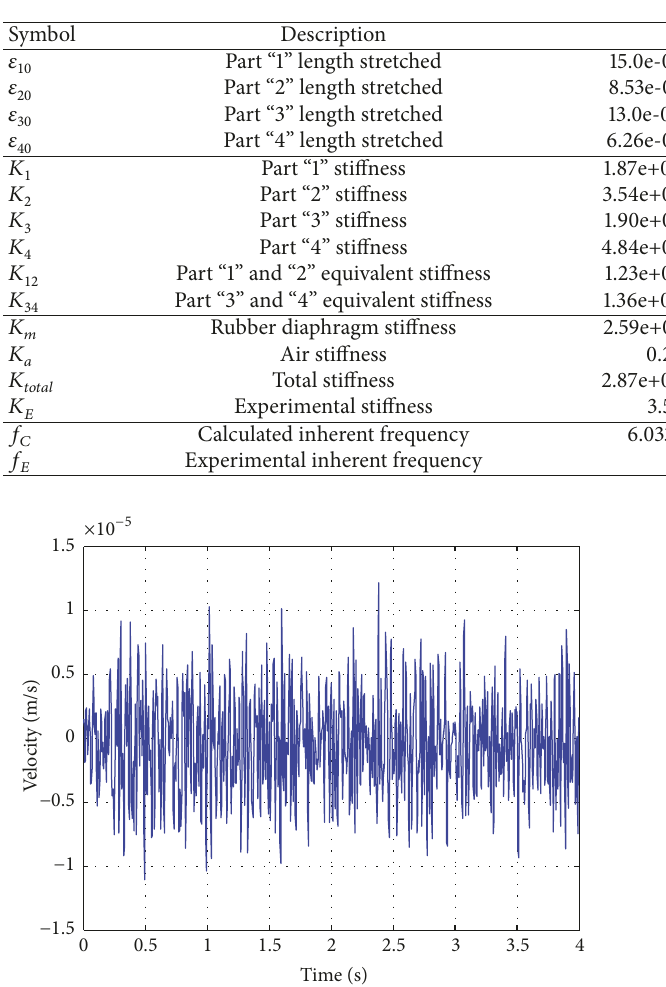
Figure 14: Ground vibration velocity curve in vertical direction versus time.